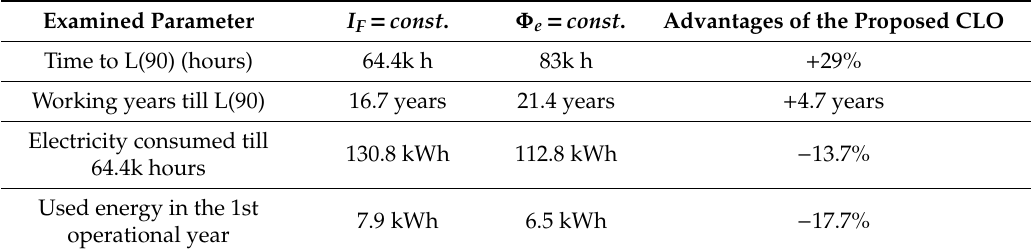
Table 3. Comparison of operation with constant forward current (700 mA) and with constant light output (425 mW), simulated with the help of our LED aging